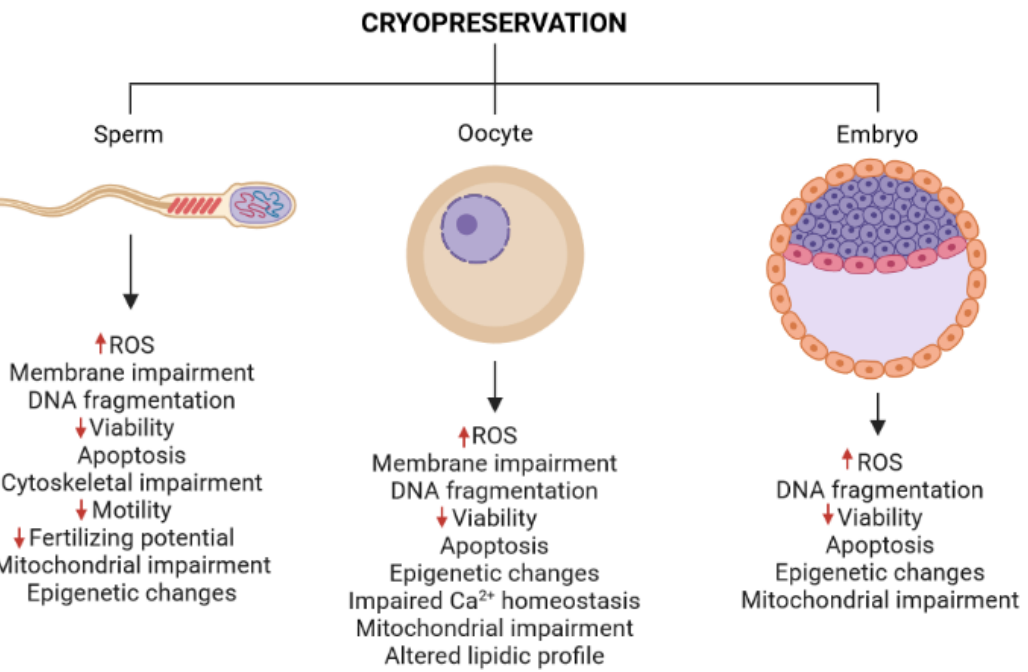
Figure 1. Effects of cryopreservation in germ cells and embryos. Cryopreservation of gametes and embryos induces molecular impairments related to metabolism, epigenetics, DNA integrity, cell death, and cytoarchitecture. ROS, reactive oxygen species. The red arrows represent increases (up arrows) or decreases (down arrows) in the indicated parameter. Figure elaborated with BioRender.